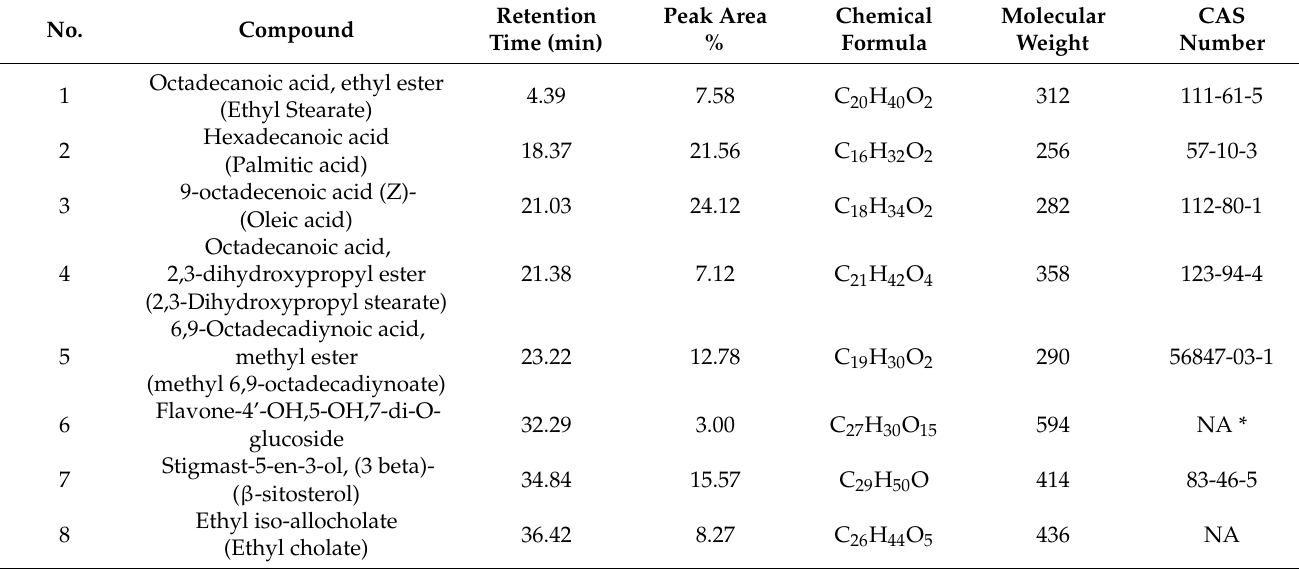
Table 1. GC-MS analysis report for the detected phytochemicals in the methanolic fruit extract of Balanites aegyptiaca .